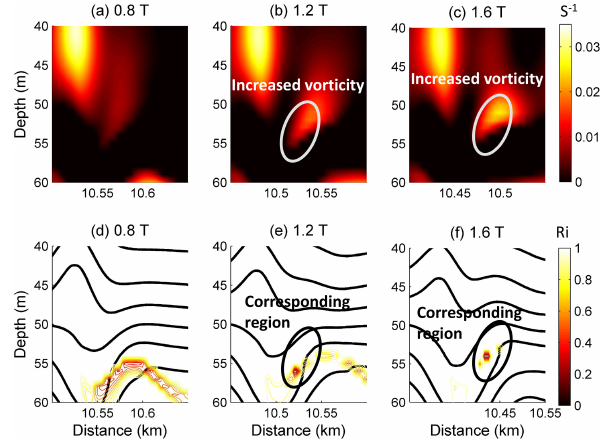
Figure 19. The vorticity spatial distributions for case O9 ( (cid:49) = 2) at (a) 0.8 T , (b) 1.2 T , and (c) 1.6 T , and the corresponding Ri values (ranges from 0 to 1) at (d) 0.8 T , (e) 1.2 T , and (f) 1.6 T